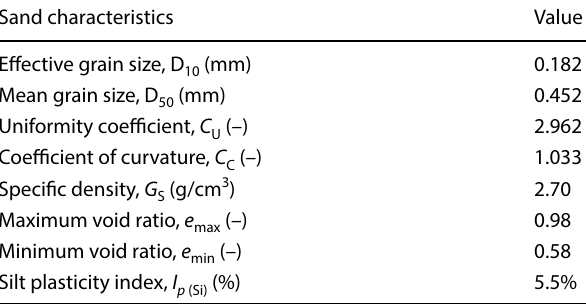
Table 1 Physical characteristics of Chlef natural